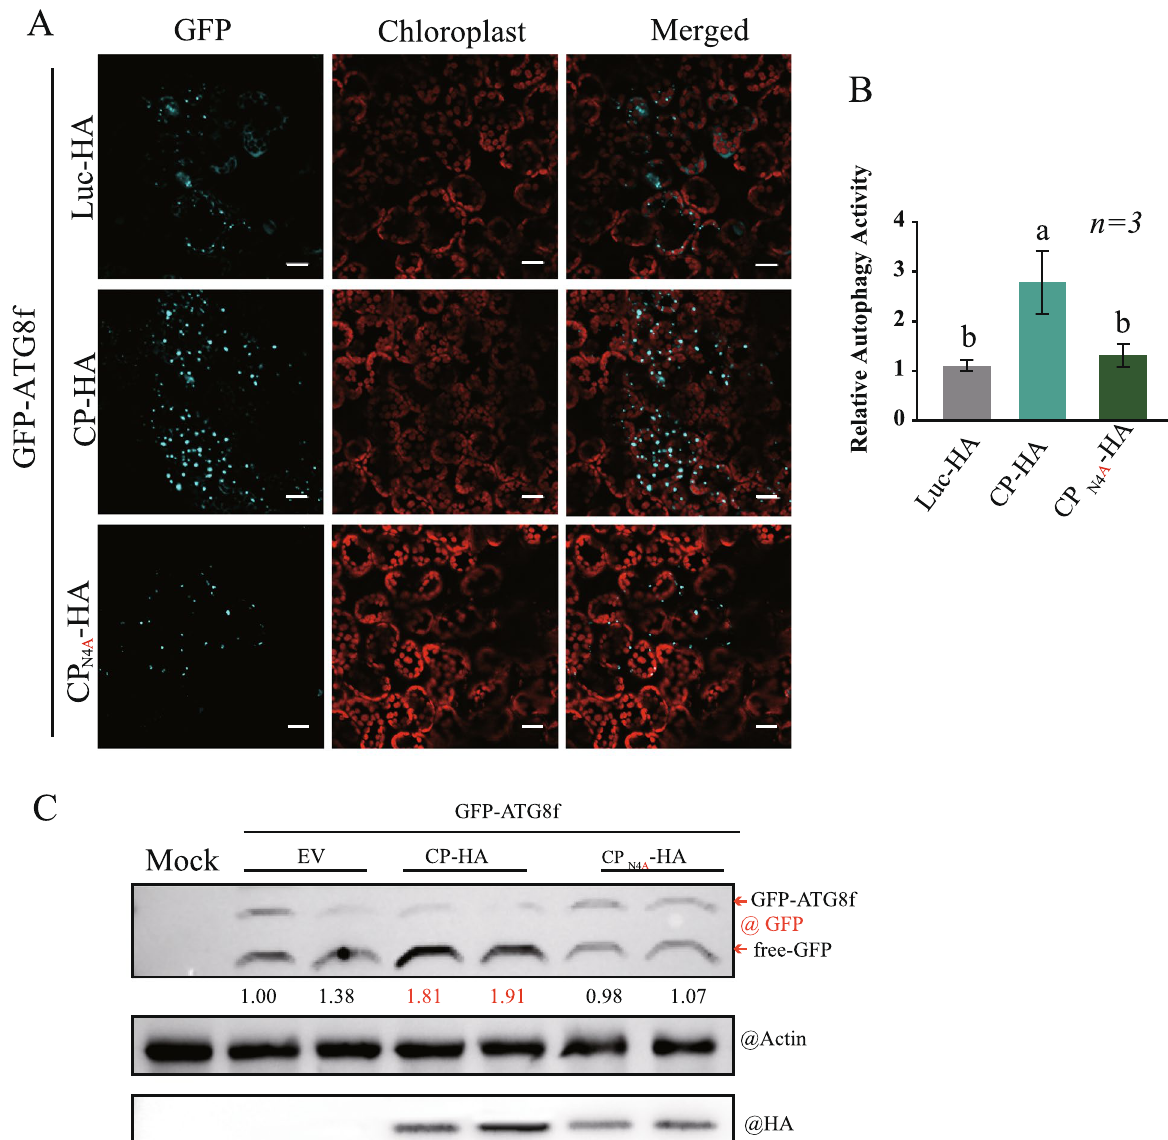
Fig. 4 Activation of autophagy by transiently expressed RSV CP. A The autophagy activity of N. benthamiana leaves expressing CP or CP N4A was assessed by the autophagy marker GFP-NbATG8f. Luc-HA, CP-HA, or CPN4A-HA were co-expressed with GFP-ATG8f in N. benthamiana using Agrobacterium infiltration. The GFP fluorescence in epidermal cells was observed by confocal laser scanning microscopy. GFP-NbATG8f fusion proteins are in cyan, and chloroplasts are in red. Scale bars, 20 μm. B The quantification of the numbers of autophagic structures in the cells of leaves described in (A). More than 100 mesophyll cells for each treatment were used for the quantification. The relative autophagic activity in Luc-HA-infected plants was normalized to control plant values, which were set to 1.00. Values represent the means from three independent experiments. The significant differences are marked with different lowercase letters over the columns (P < 0.05, one-way ANOVA). C The protein samples obtained from (A) were subjected to western blot analysis using anti-GFP, anti-HA, and anti-actin antibodies. The accumulation of GFP was normalized to actin. The ratio of free GFP via total GFP (GFP-ATG8f plus free-GFP) was compared to the control sample (EV), which was set to